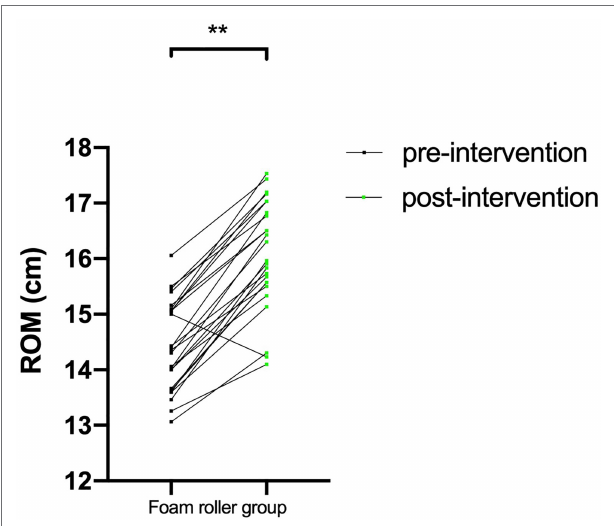
FIGURE 3 | The change in ankle dorsiflexion ROM in the FR group before and after foam roller intervention. FR, foam roller; ROM, range of motion; ** p < 0.01.